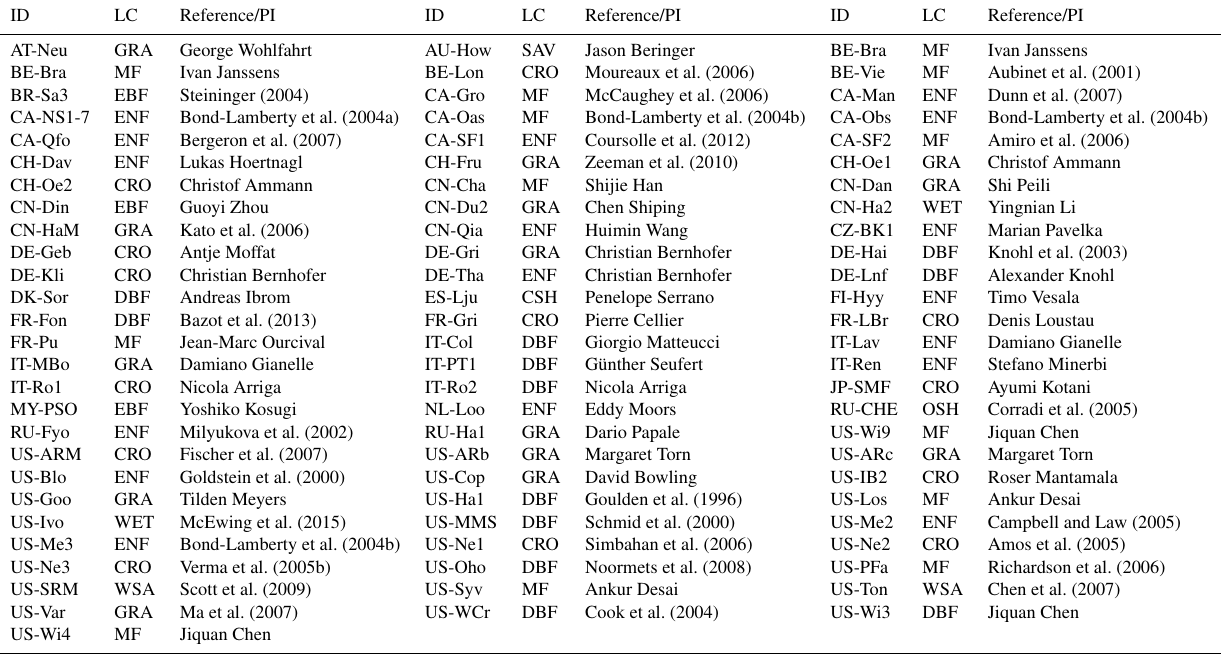
Table 1. List of the FLUXNET sites used in this study together with their FLUXNET code (ID), IGBP land cover (LC), and official reference or principal investigator (PI). The CA-NS1-7 refers to seven stations closely located and run by the same group. ID LC Reference/PI LC Reference/PI